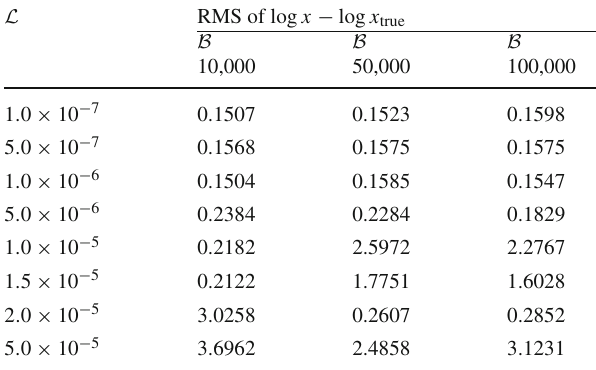
Table 1 Resolution of log x reconstruction after 200 epochs of training with different values of initial learning rate L and batch size B